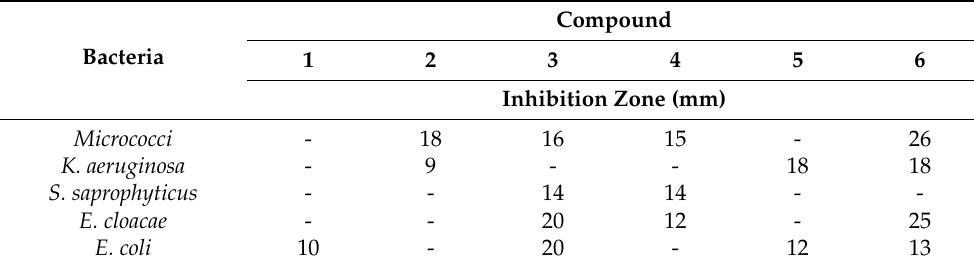
Figure 12. Monovalinoyl curcumin. Table 6. Antibacterial activity of curcumin bioconjugates (values represent the zone of inhibition in mm) against multi-resistant bacterial strains. (-) Resistant. ( 1 ) curcumin; ( 2 ) 4,40-(di-O-glutamoyl)- curcumin; ( 3 ) 4,40-(di-O-valinoyl) curcumin; ( 4 ) 4,40-(di-O-glycinoyl) curcumin; ( 5 ) monoglycinoyl curcumin; ( 6 ) monovalinoyl curcumin.